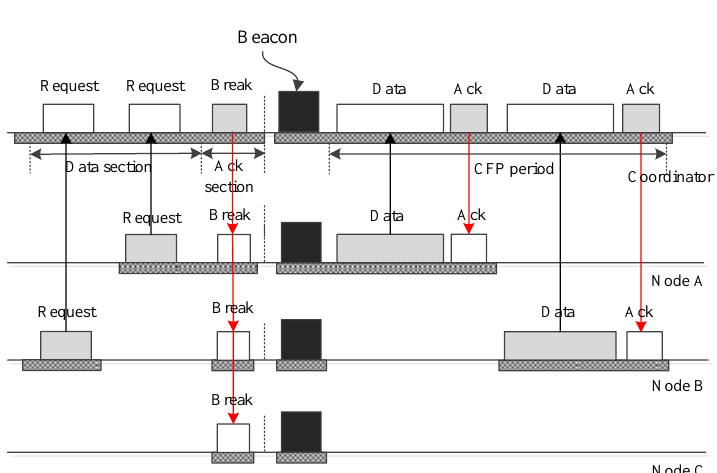
Figure 13. Only one node sends big data to the coordinator.